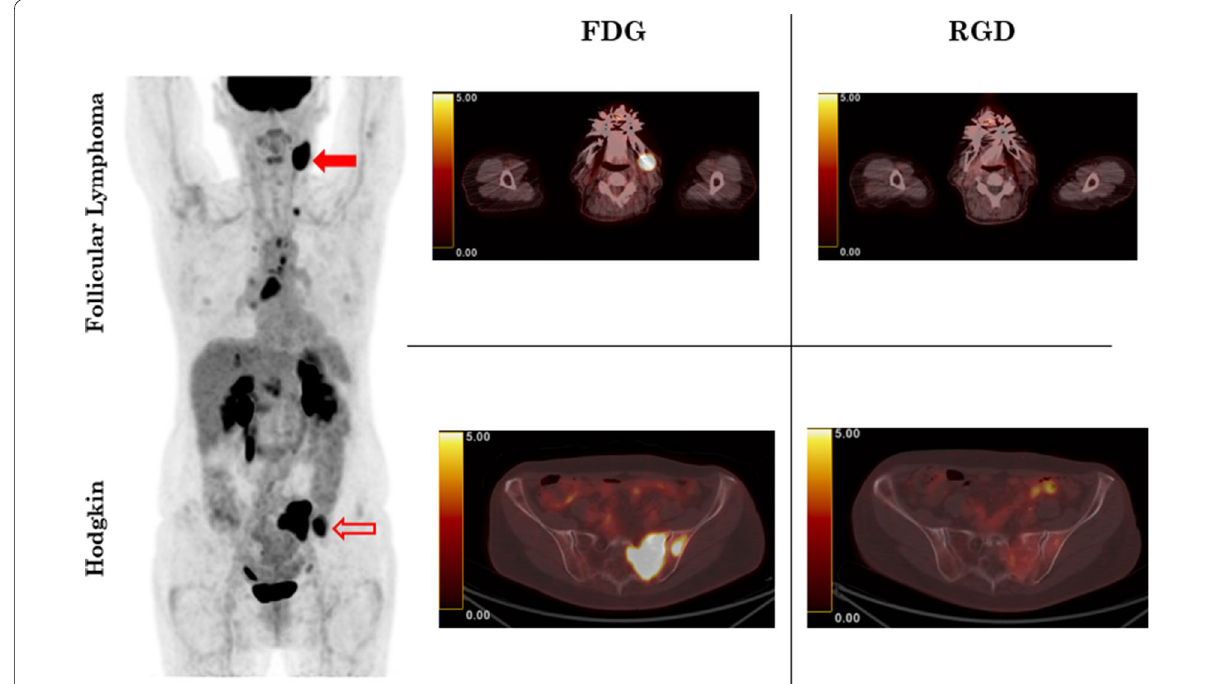
Fig. 3 FDG maximum intensity projection (left) in patient presenting with synchronous biopsy-proven follicular (full red cross) and Hodgkin (empty red cross) lymphoma. On axial PET/CT (middle and right column), both lesions had significant FDG uptake (middle column). No RGD uptake in follicular lymphoma (right column, upper row). Significant RGD uptake in Hodgkin lymphoma (right column, bottom row)